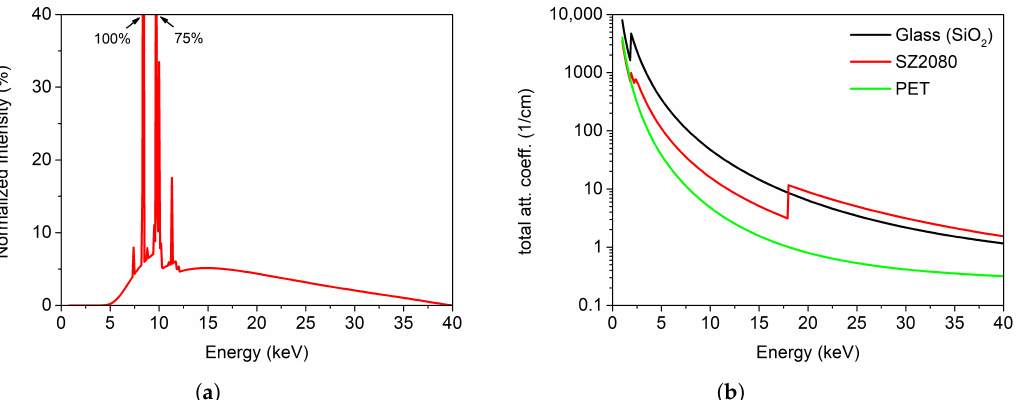
Figure 4. ( a ) X-ray spectrum of the used setup calculated with aRTist (parameters see Section 2.4). Note that most photons are created in the low-energy range around 10kV (characteristic lines of tungsten) and at the mean energy of the bremsstrahlung at around 15kV. ( b ) Total linear attenuation coefficients of glass (SiO 2 , ρ Si = 2.2g · cm − 3 ), SZ2080 (C 36 H 68 O 20 Si 4 Zr, ρ SZ 2080 = 1.2g · cm − 3 ) and